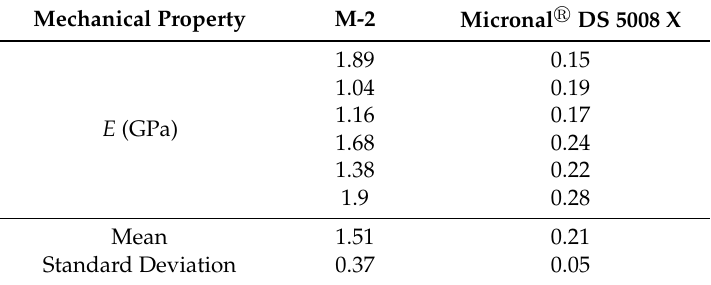
Table 2. Elastic modulus results of M ‐ 2 and Micronal ® DS 5008 X.